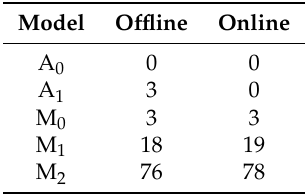
Table 2. Average usage frequency (rounded in %) of the various models on the offline dataset (226 households) and on the online dataset (20 households). Model